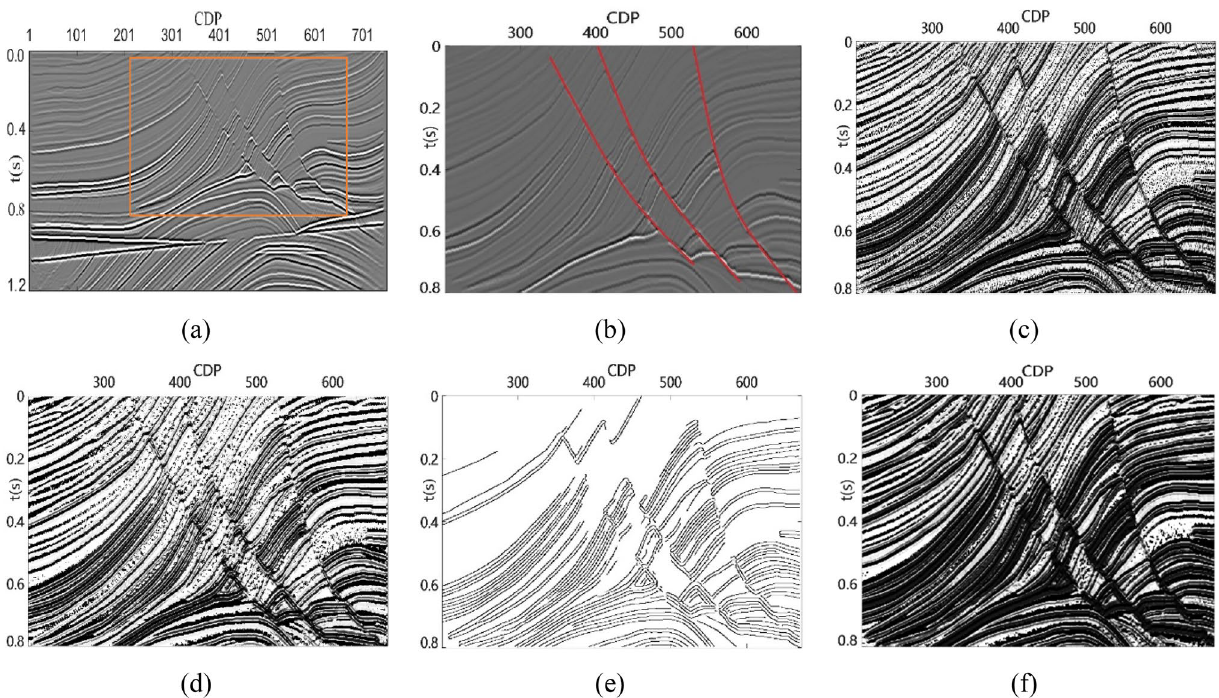
Fig. 3 Results of the Marmousi-model test obtained by different methods. a Marmousi-model; b close-up of the detection area; c LBP/VAR method; d median filtering-LBP/VAR method; e guided filtering-Canny method; and f guided filtering-LBP/VAR